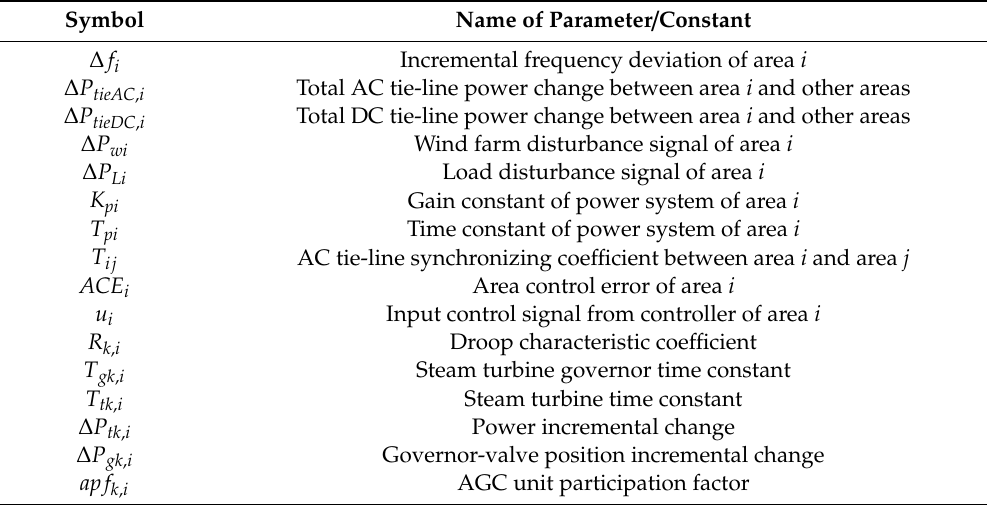
Table 1. Meanings of symbols of state space